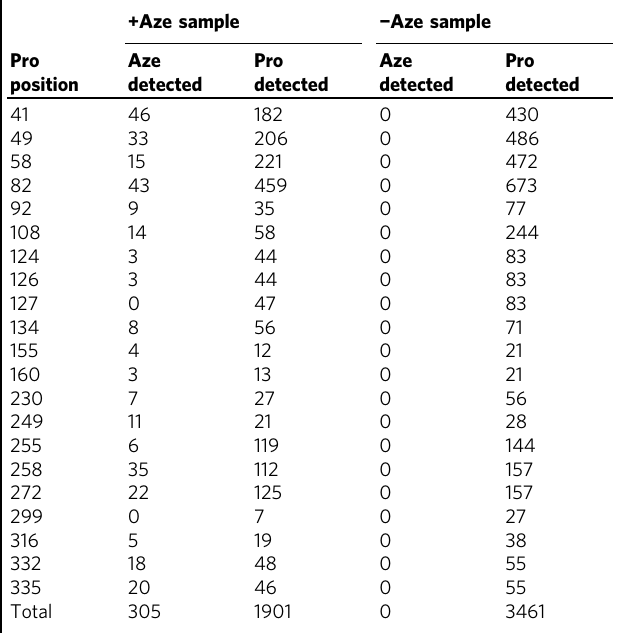
NATURE COMMUNICATIONS | 8:2281 | DOI: 10.1038/s41467-017-02201-z |